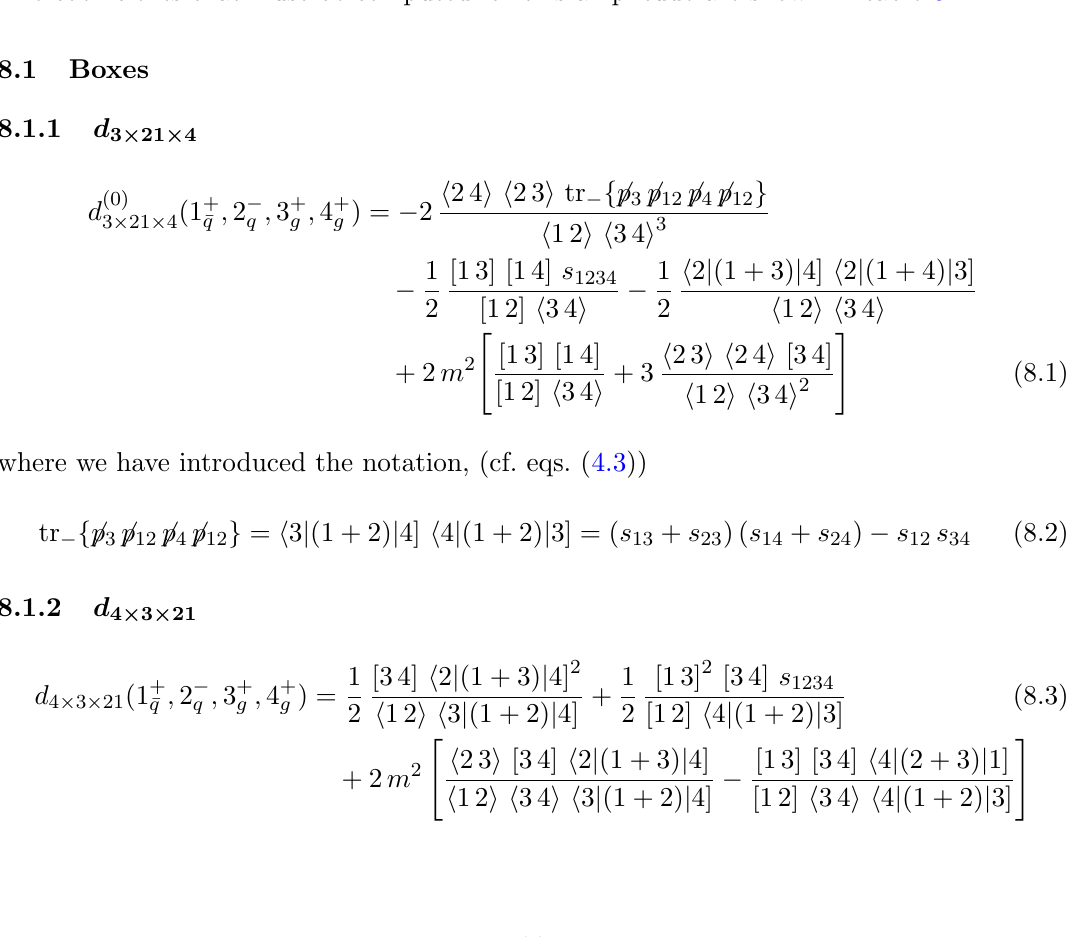
Table 5 . Minimal set of integral coe(cid:14)cients for H 34 H 34 (1 + ; 2 (cid:0) ; 3 + ; 4 (cid:0) ) together with the related coe(cid:14)cients that can be obtained from the base set. (cid:22) q q g g 4